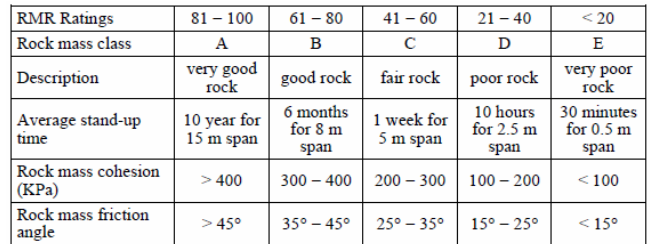
Table 2: Rock mass classes determined from total ratings and meaning (Bieniawski, 1989)